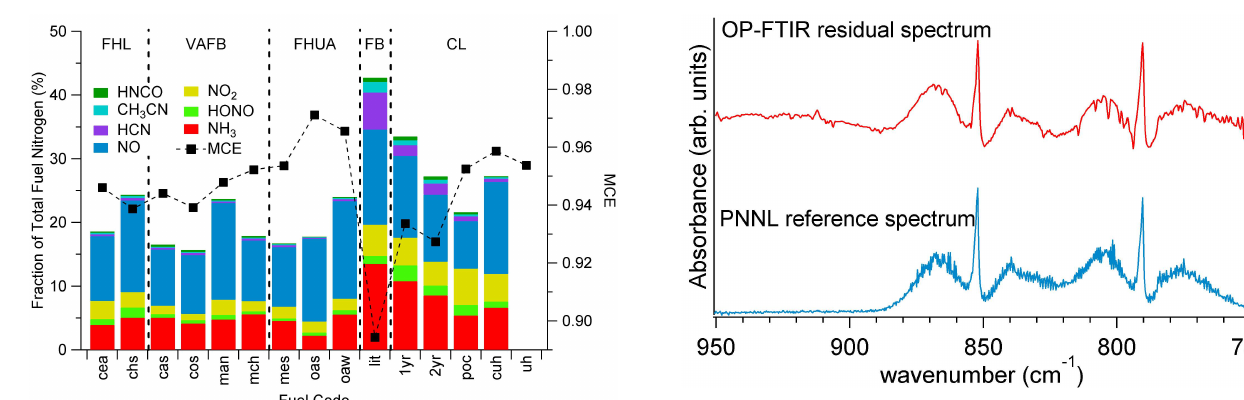
Fig. 5. Contribution of gas-phase nitrogen-containing species to the nitrogen balance. The inclusion of modified combustion efficiency (MCE) shows an anticorrelation between total nitrogen accounted for and MCE.